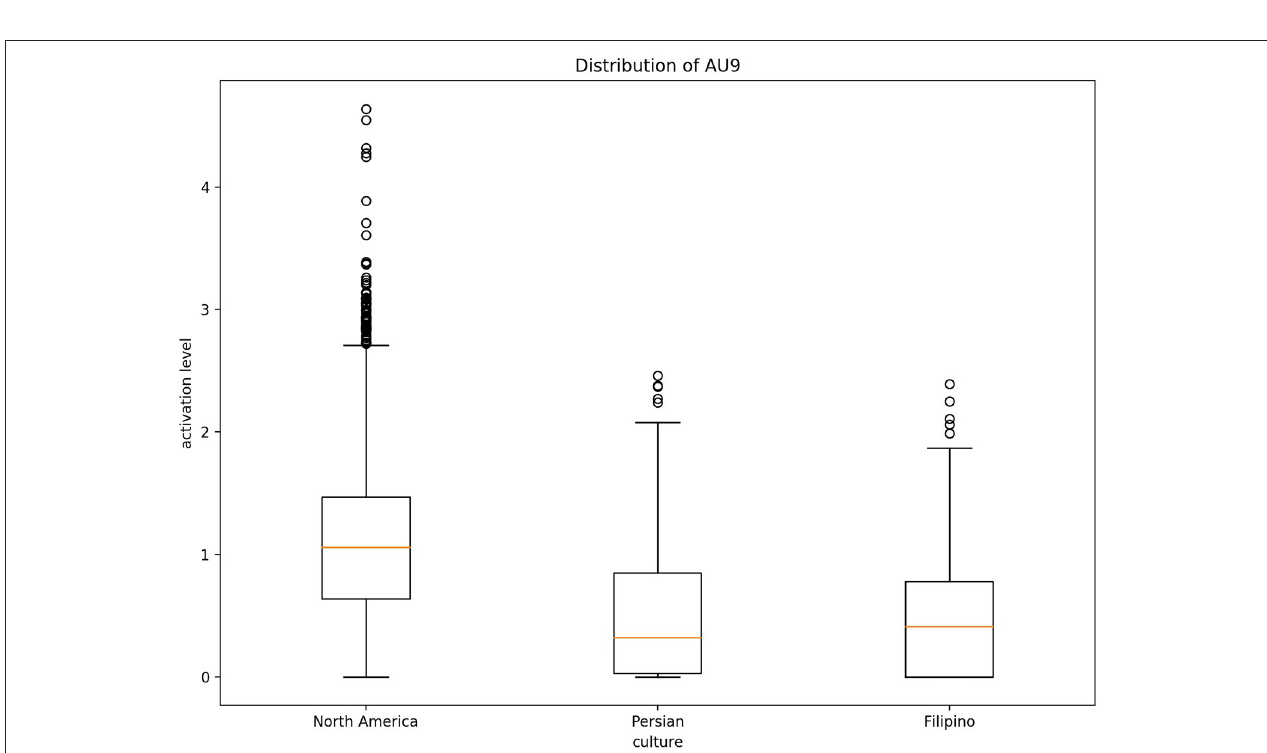
FIGURE 5 | Distribution of AU9 cross-culturally for